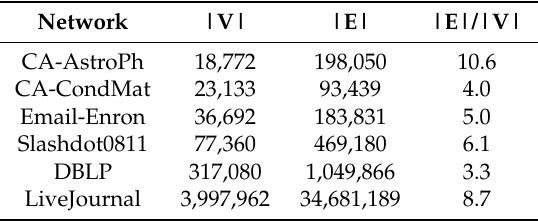
Table 1. Real-life social networks.